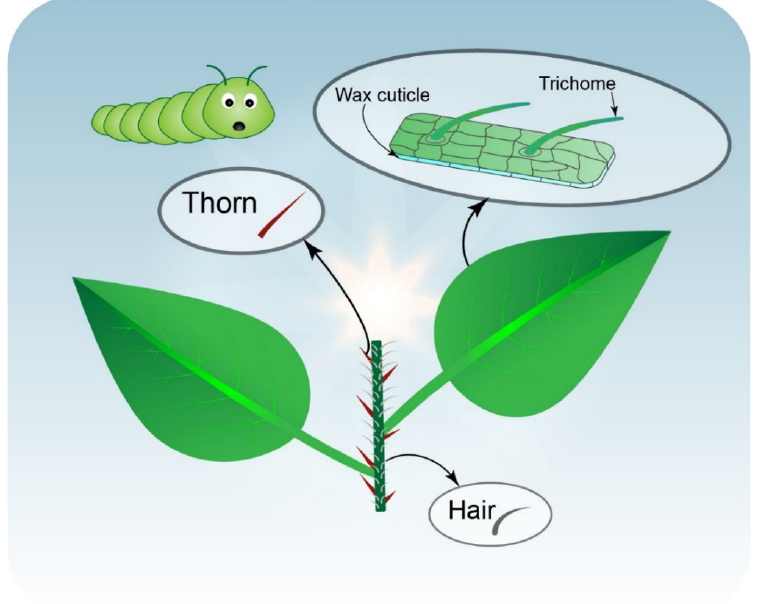
Figure 1. Schematic diagram of plant physical barriers against herbivory attack, including wax cuticle layers, trichomes, thorns, and hairs.